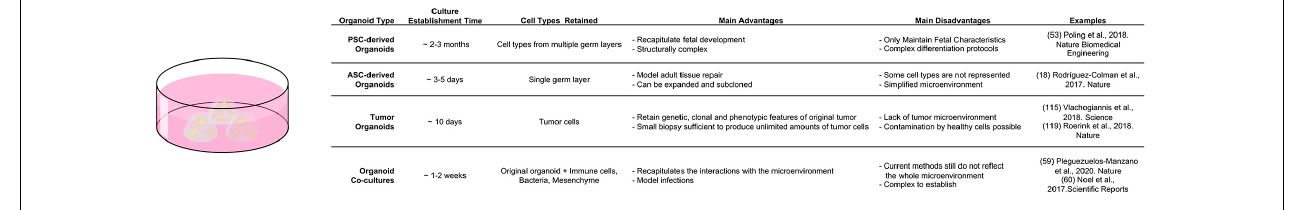
FIGURE 4 | Comparison of different organoid systems to assess fate determination and plasticity in homeostasis and